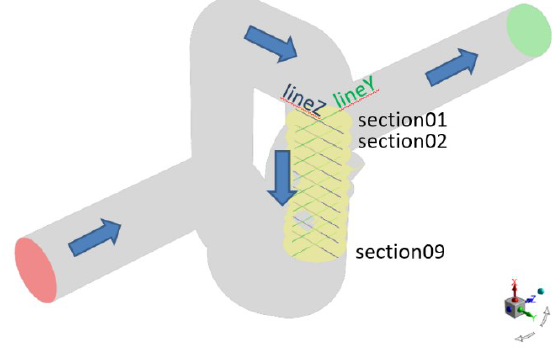
Fig. 5 Cross-section planes –